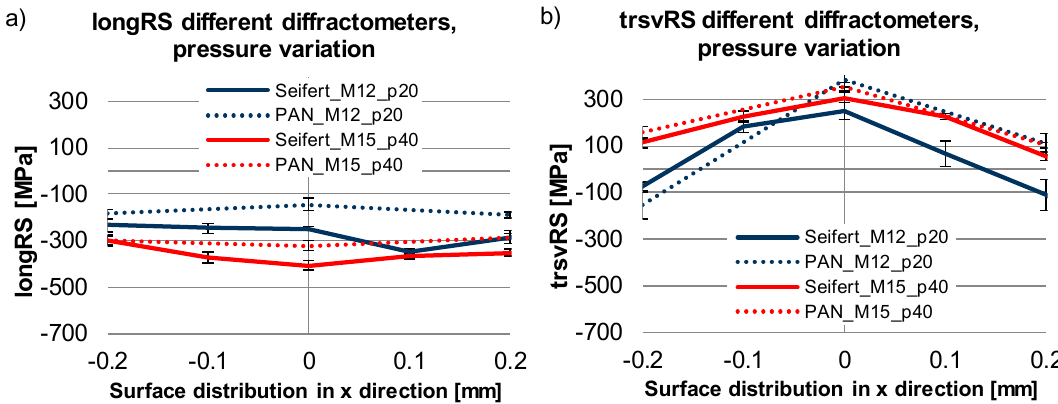
Figure 4. In-trace residual stress surface distribution in ±x direction, by variation of the measurement device (Seifert XRD 3000 PTS or PANalytical Empyrean) and the DR pressure (designation “p”); ( a ) longitudinal residual stresses (longRS) and ( b ) transverse residual stresses (trsvRS).